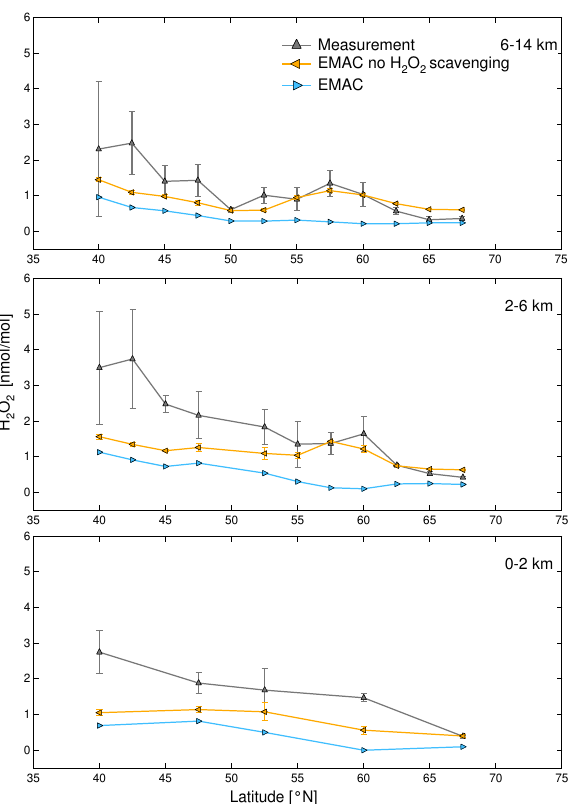
Fig. 10. Sensitivity study of H1 with the EMAC model. Latitude gradients of H 2 O 2 for HOOVER 1 in October 2006: Data is subdi- vided into 3 altitude intervals representing the BL, the MT and the UT. The median values of in-situ measurements (grey), standard EMAC simulations (blue) and EMAC simulations with deactivated cloud scavenging for H 2 O 2 (orange) are plotted together with 2 sigma as error bars.